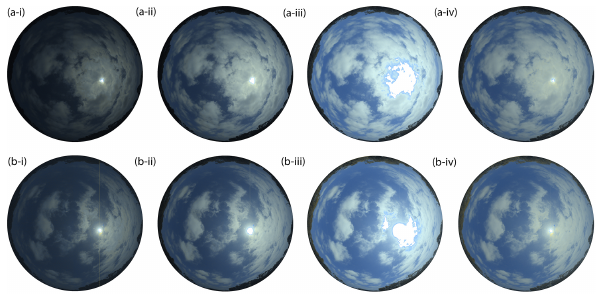
Figure 9. HDR images from USI 1.8 in April and May 2013, show- ing a variety of sky conditions. Images required intensity rescaling for display